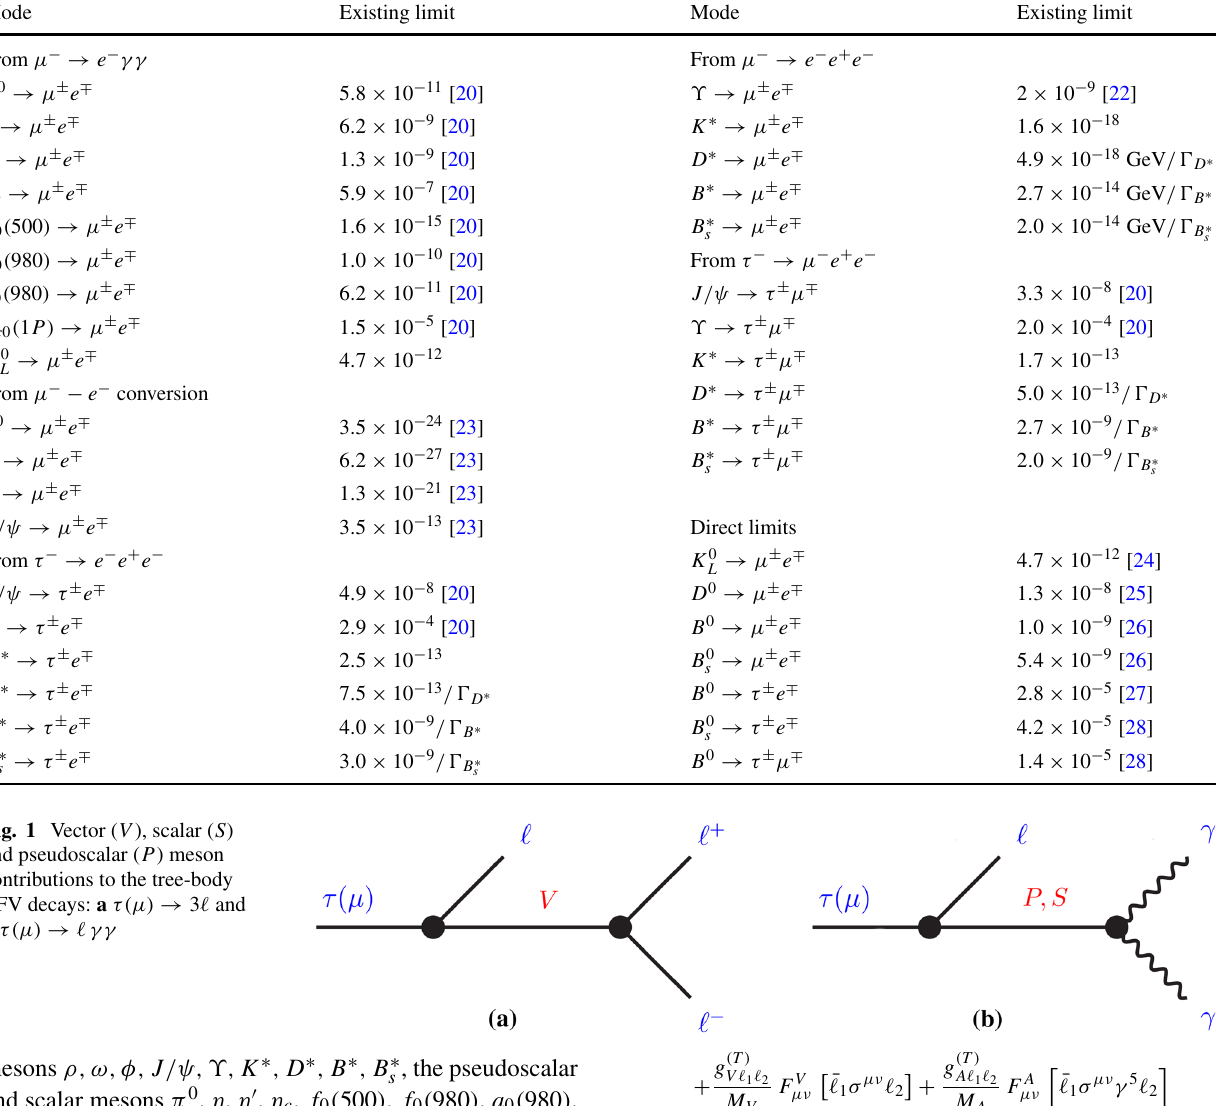
limit to our knowledge. The limits for the vector mesons K ∗ , D ∗ , B ∗ , and B ∗ s were derived from Eqs. (5) and (6). See a comment about their viability at the end of Sect. 2